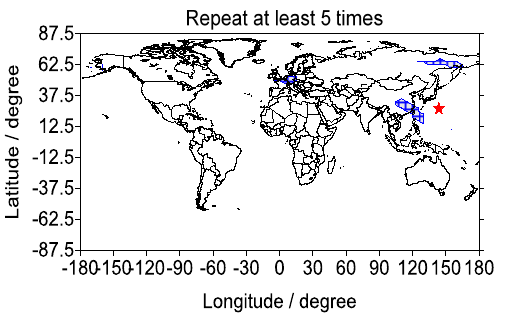
Fig. 20. Locations of the 30-day extreme enhancement that repeatedly appeared at various time points on 19 December 2010. quake was negative. The ionospheric anomalies discussed